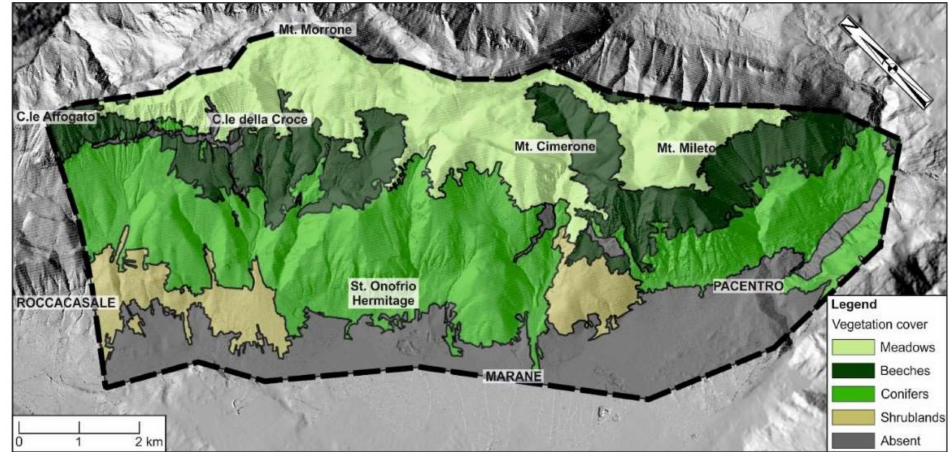
Figure 5. Pre-wildfire vegetation cover map (modified from [49]). The black dashed box indicates the location of the study